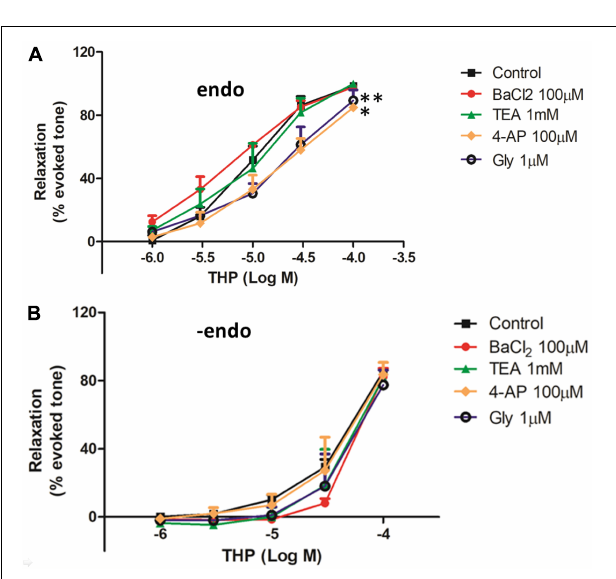
FIGURE 5 | The effect of K + channels on THP-induced vascular relaxation. The rat aortas were with intact endothelium (endo) (A) or mechanical remove the endothelium (-endo) (B) . The aortic rings were pre-incubated with the voltage-dependent K + channel (Kv) blocker 4-aminopyridine (4-AP), ATP-sensitive K + channel (KATP) blocker glibenclamide (Gly), Ca 2 + -activated K + channel (KCa) blocker tetraethylammonium (TEA), and inward rectifying K + channel blocker (BaCl 2 ) on the indicated concentration for 30 min, then the vascular contracted with Phe (1 µ M) and relaxed by the accumulative addition of THP (1–100 µ M). Vascular relaxation presented as a percentage of the evoked tone. Results were means ± SEM of more than three experiments. ∗ P < 0.05, ∗∗ P < 0.01 versus control